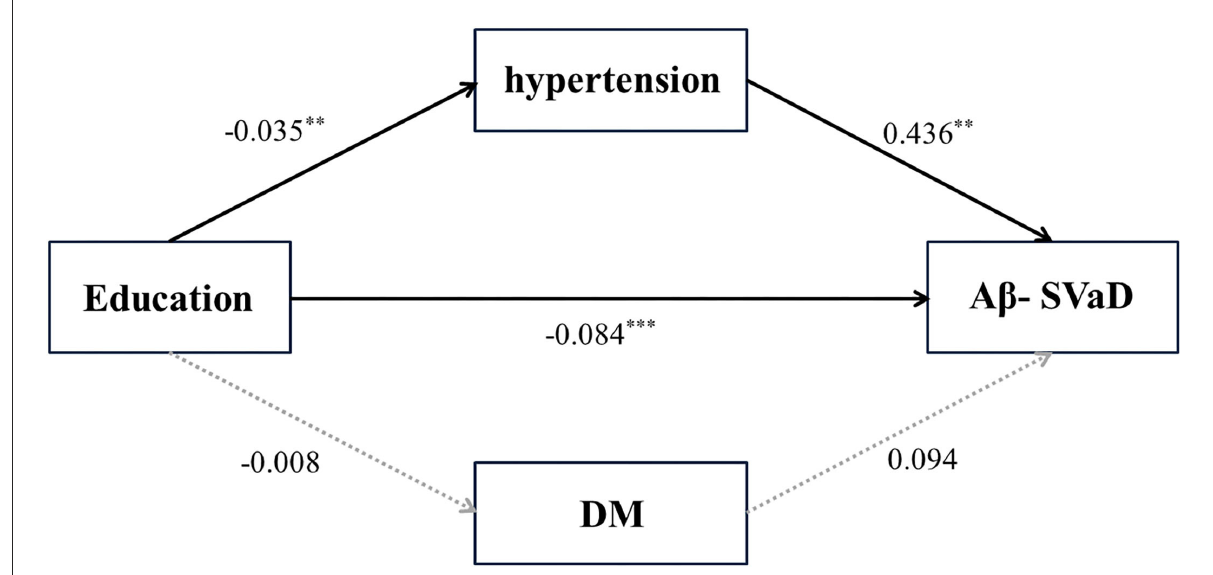
TABLE 3 Relationship between education, vascular risk factors, and SVaD.